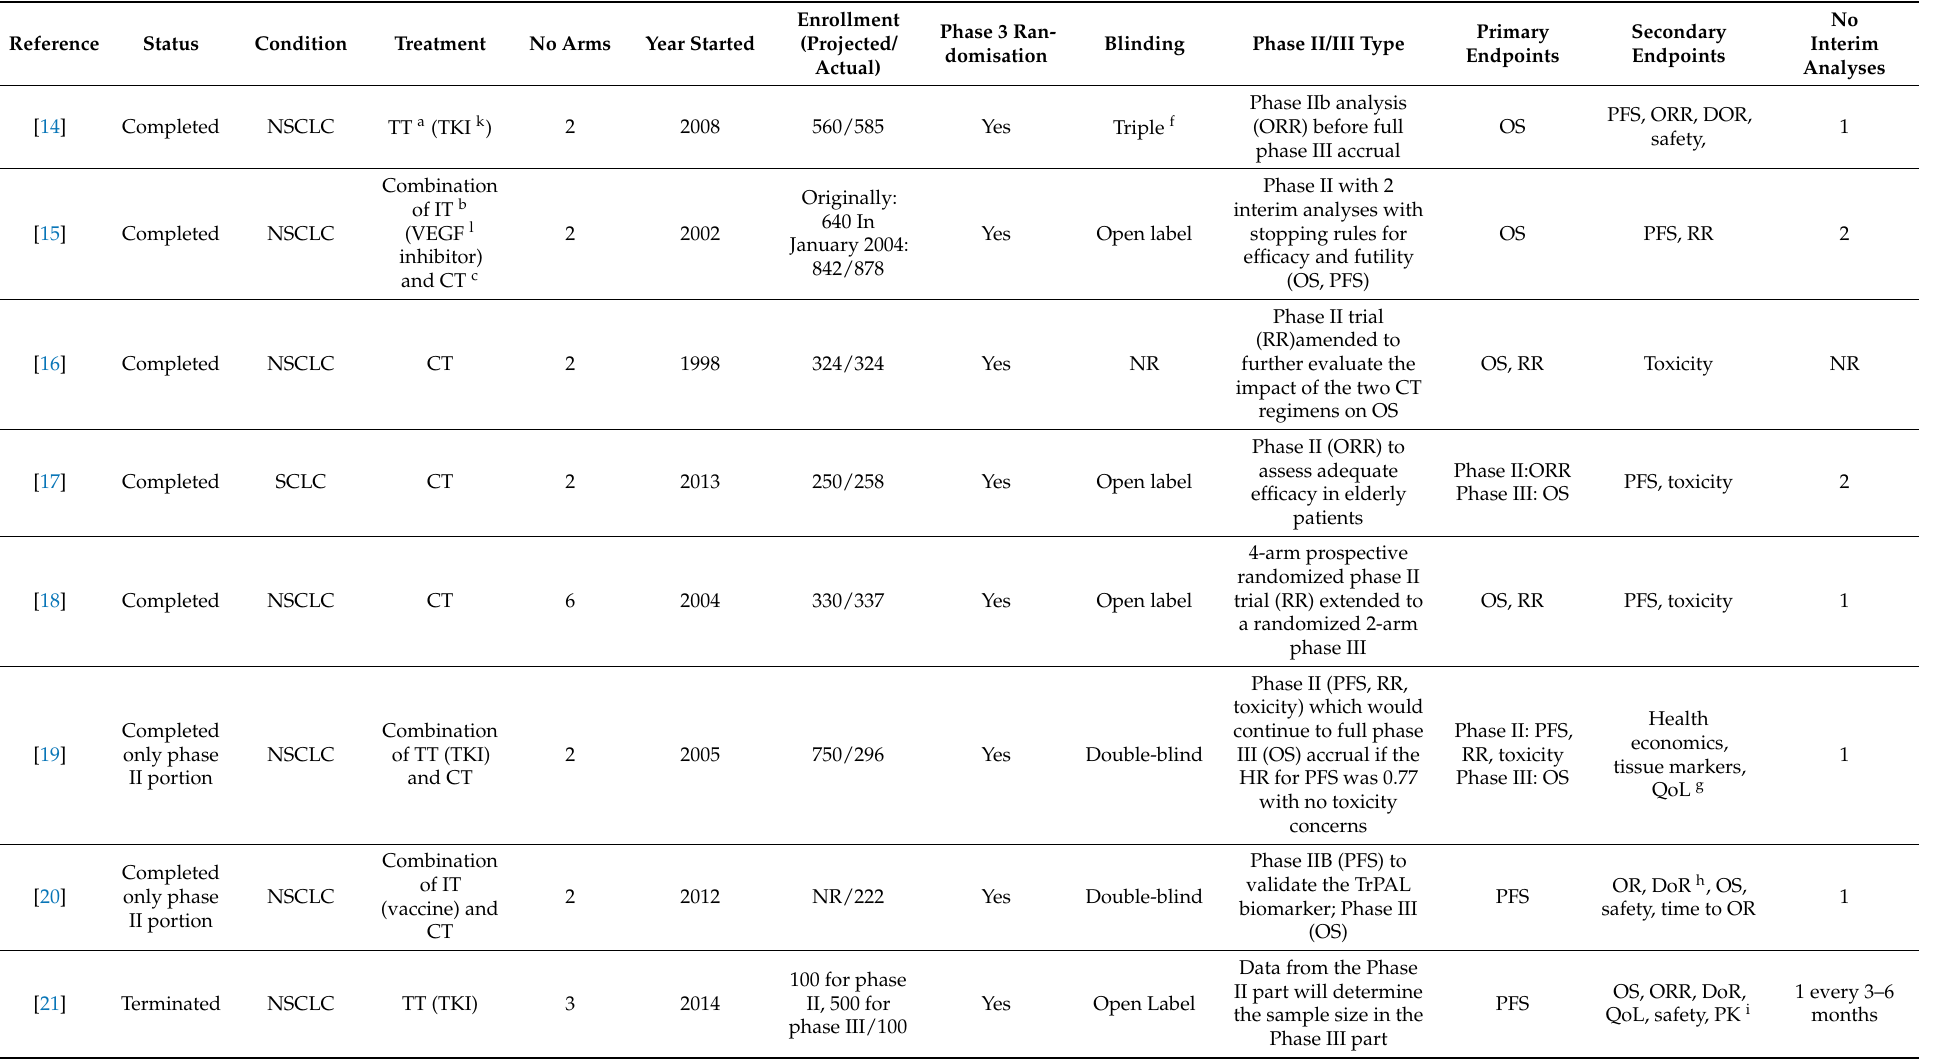
Table 2. Phase II/III trials with aggressive inefficacy/futility